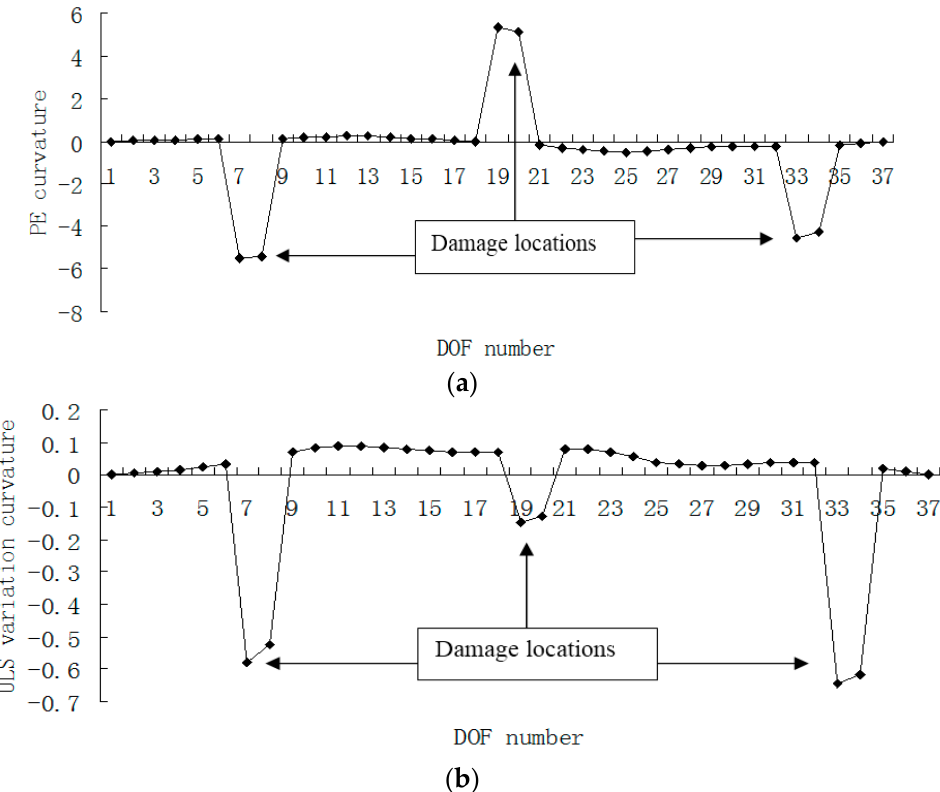
Figure 16. ( a ) Damage index (PE curvature) map using the first four modes without noise when elements 7, 19 and 33 are damaged; ( b ) Damage index (ULS variation curvature) map using the first four modes without noise when elements 7, 19 and 33 are damaged (×10 − 3 ).